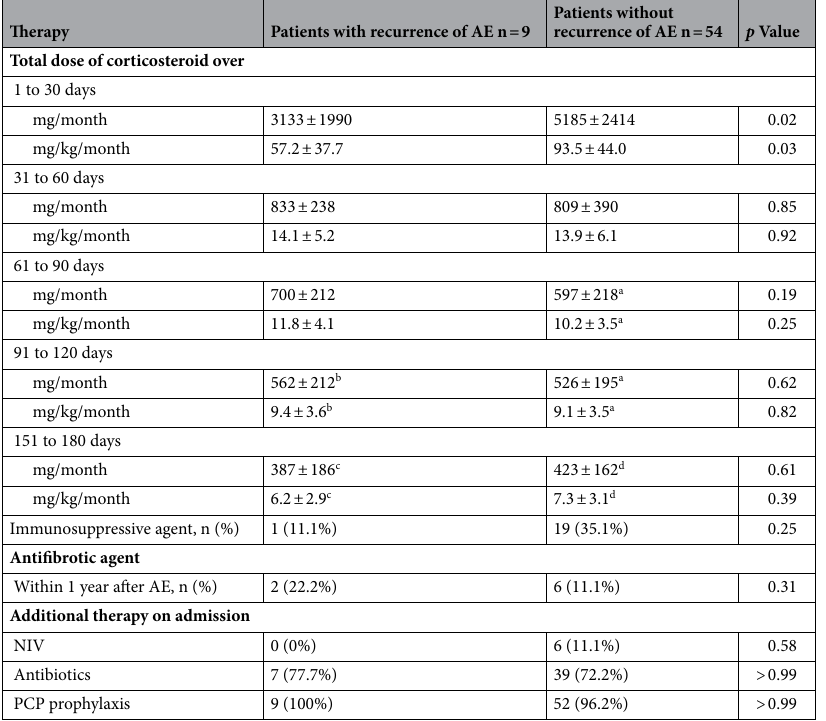
Table 3. Therapies after onset of the first acute exacerbation in patients with and without subsequent recurrence of acute exacerbation. Values are shown as actual numbers or means ± standard deviation. a n =